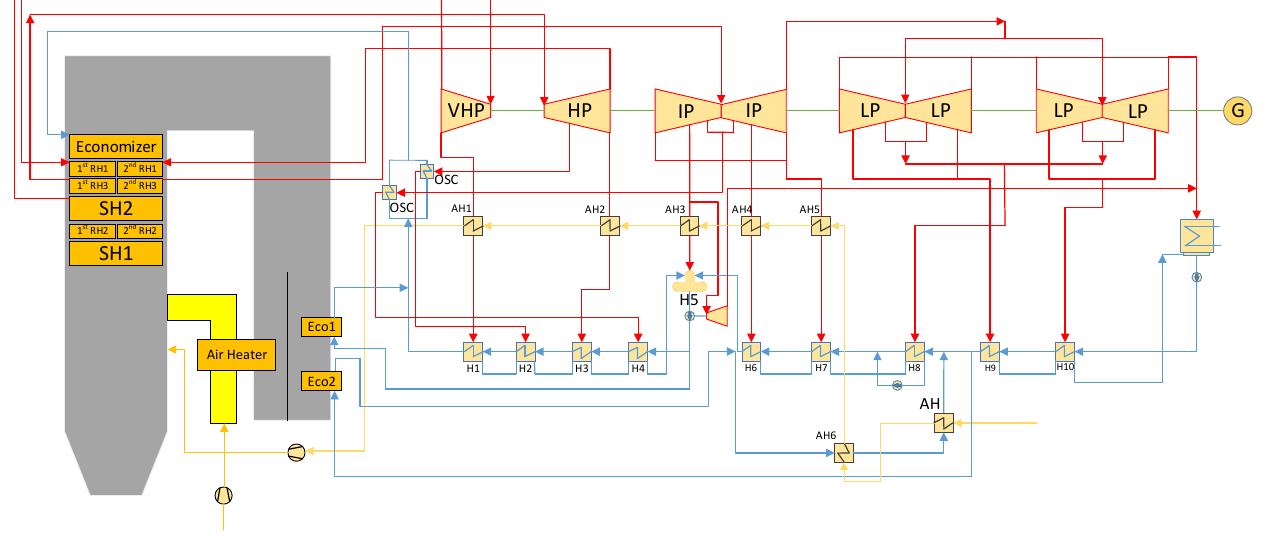
Figure 13. Flowchart of new system 3.